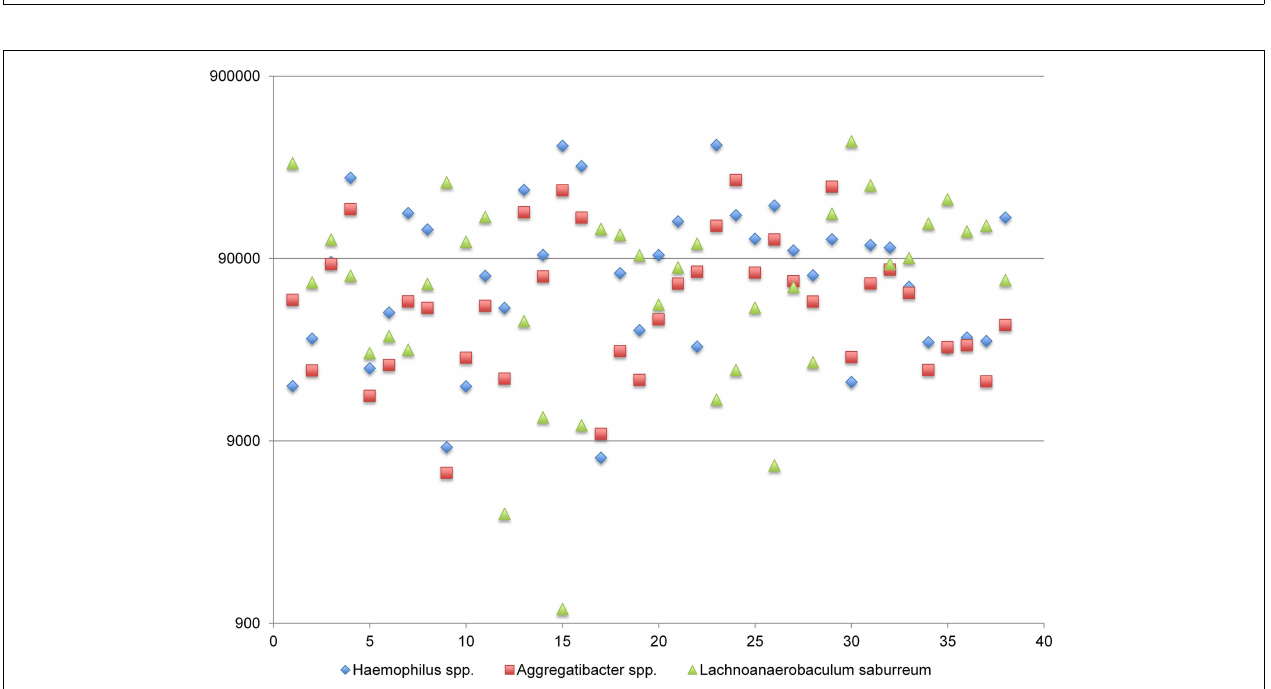
FIGURE 7 | Functional Network in dental plaque microbiota, complex III. The y-axis displays read counts on a log scale. The x-axis displays subjects in the order shown in Table 1 .